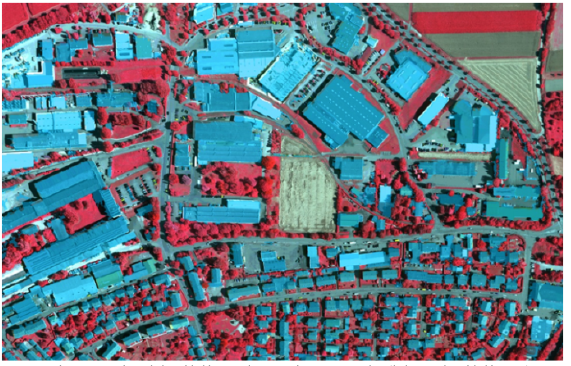
Fig. 2. Final building detection result (blue: buildings).